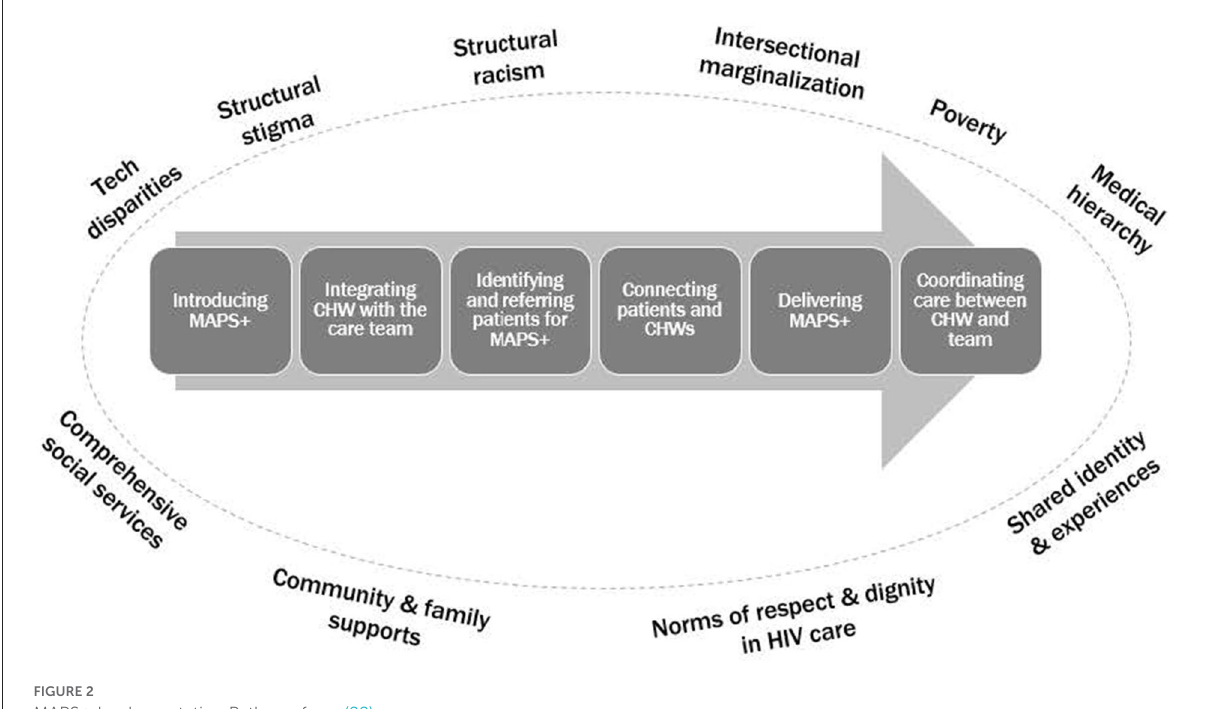
FIGURE2 MAPS + Implementation Pathway from